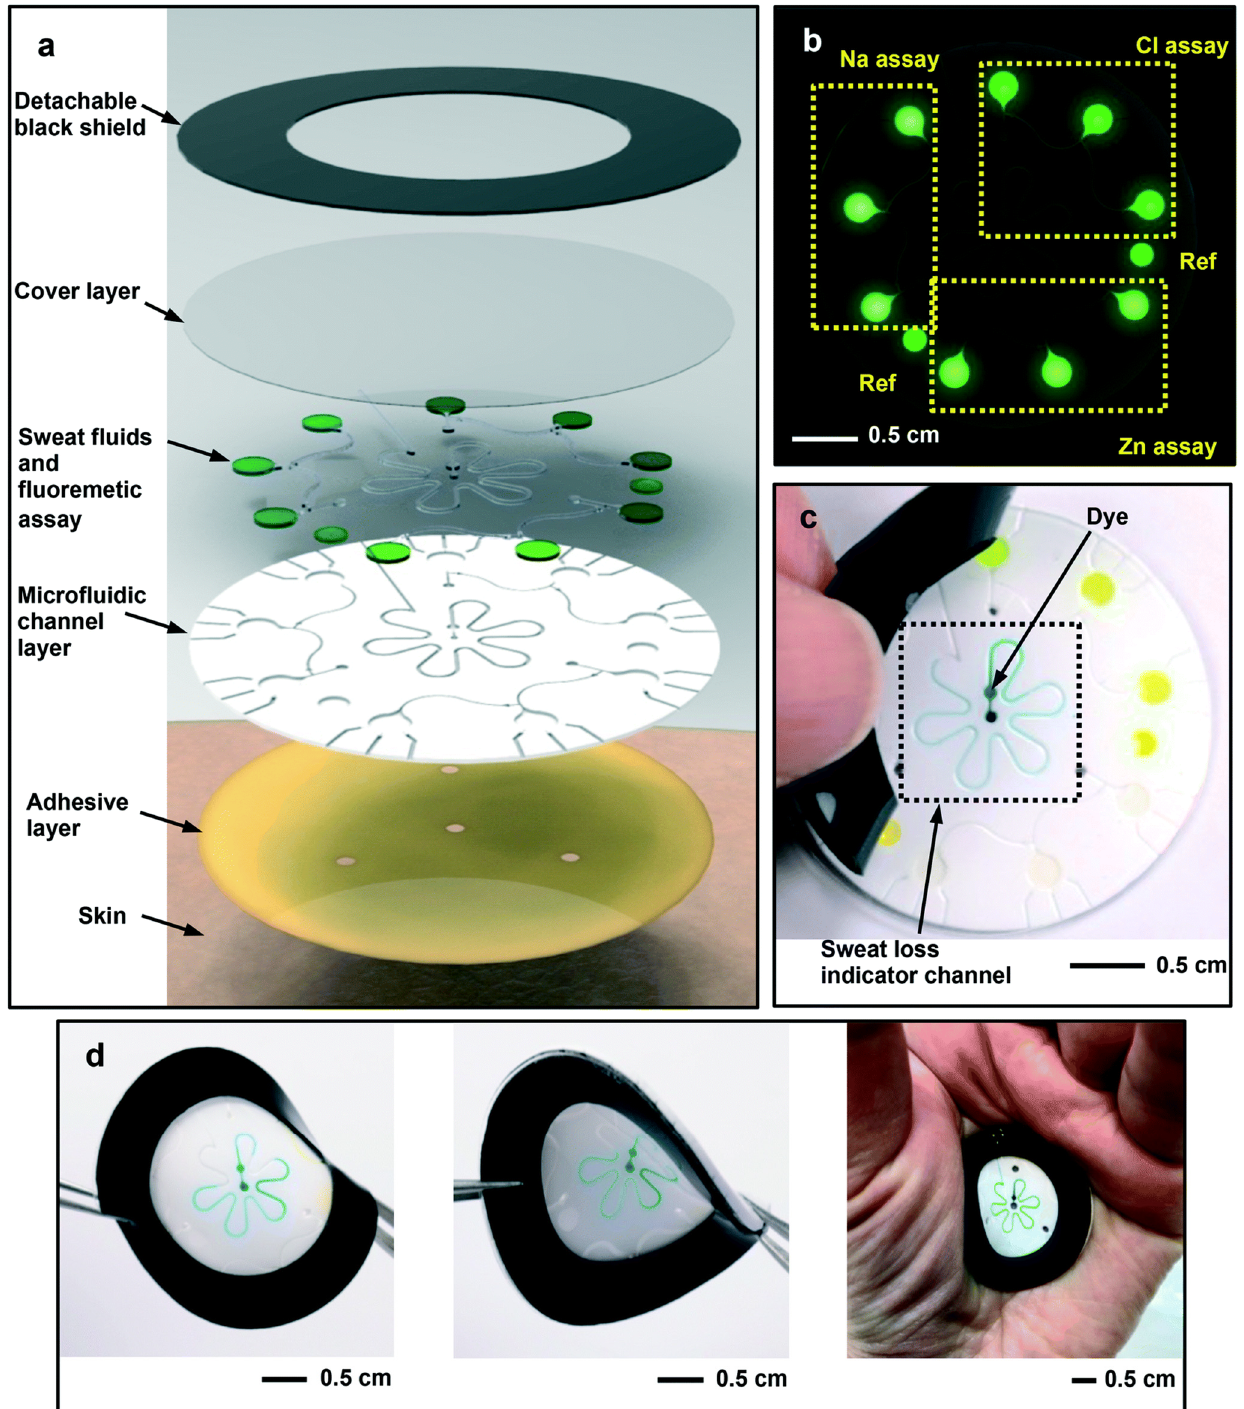
Figure 4. Schematic design of the ( a ) microfluidic fluorescence sensor in to detect the chloride, sodium, and zinc present in the sweat sample; ( b ) fluorescence response of different components; ( c ) peeling of black silicone shield from the sensor surface; ( d ) twisting properties of the device. Reprinted with permission from Lab on a Chip , Copyright 2018, Royal Society of Chemistry [54].